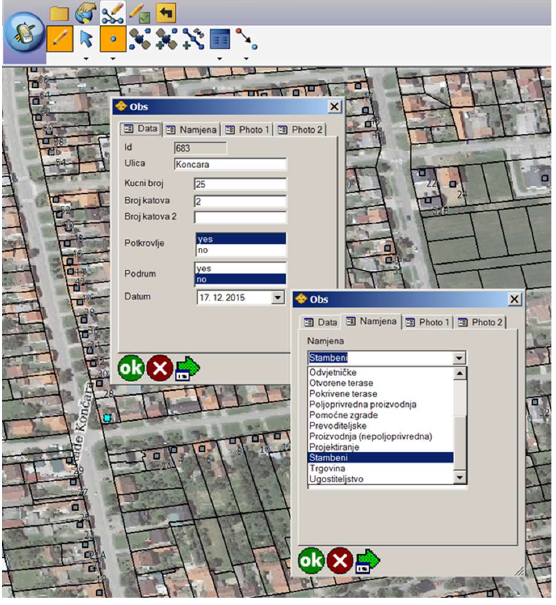
Figure 3. Snapshot of the form for collection and editing the feature attributes to the observed field measurement